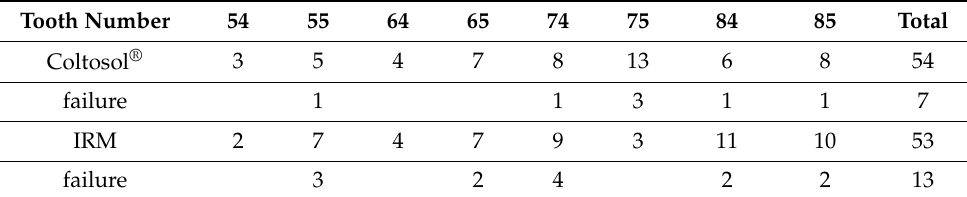
Table 3. Treatment and failures by tooth